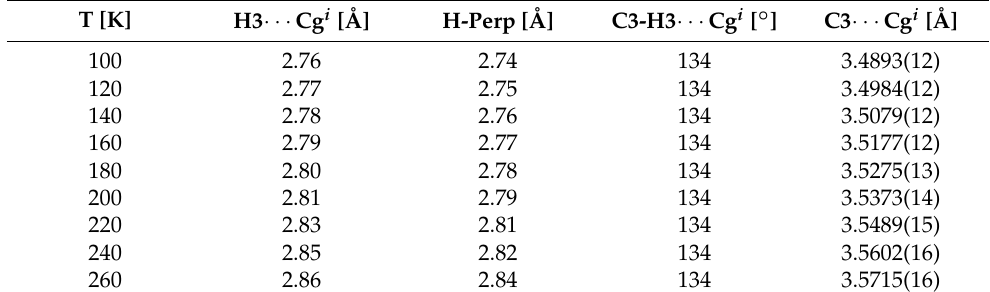
Table 4. Geometries of C–H · · · π interactions in (I) . Cg : center of gravity of six-membered